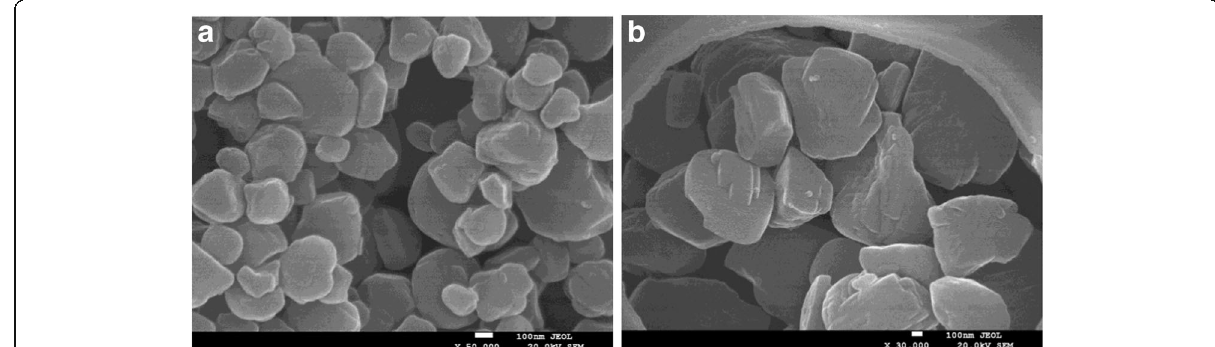
Fig. 1 a SEM image of HPS-1 support and b Ag@HPS-1